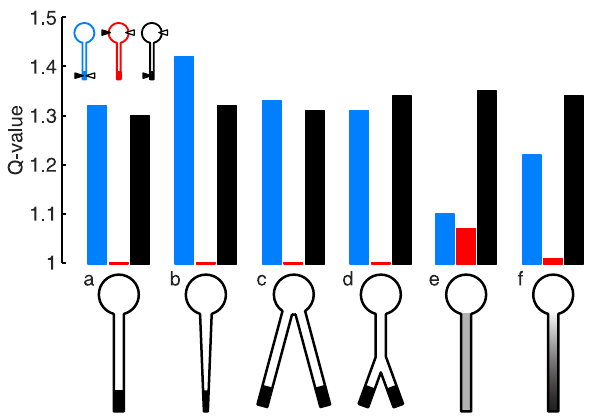
Figure 5. Differential filtering of somatic and dendritic input persists for a variety of cell morphologies and a gradual distribution of the active current. Q-values of the dendritic input impedance (blue), somatic input impedance (red), and dendro-somatic transfer impedance (black). a : The default model from Figures 1B, 2C, 3, and 4 (length of passive cable l ~ 900 m m, length of active distal end l d ~ 100 m m, dendrite diameter d ~ 2 m m, peak conductance in active segment (cid:2) gg h ~ 23 : 9 nS). b : Tapering of diameter towards the dendritic end (dendrite diameter gradually decreases from d ~ 2 m m to d ~ 1 m m). c : Neuron with two dendrites, both with the same parameters as model a . d : Branching neuron (length of primary dendrite l ~ 500 m m, length of passive parts of both daughter dendrites l ~ 400 m m, length of active dendritic ends l d ~ 100 m m). e : Uniform distribution of h-conductances (peak conductance density (cid:2) gg h ~ 0 : 38 mS/cm 2 ). f : Exponential